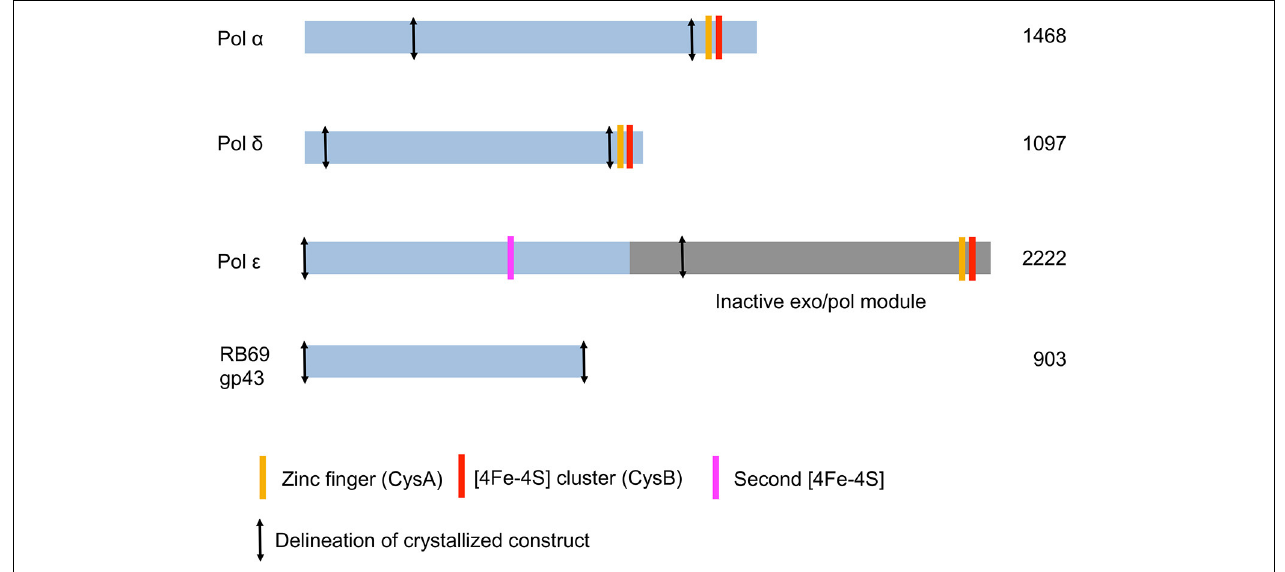
FIGURE 2 | Schematic diagram of the three Saccharomyces cerevisiae replicative DNA polymerases α , δ , and ε . The DNA polymerase from bacteriophage RB69 is shown for